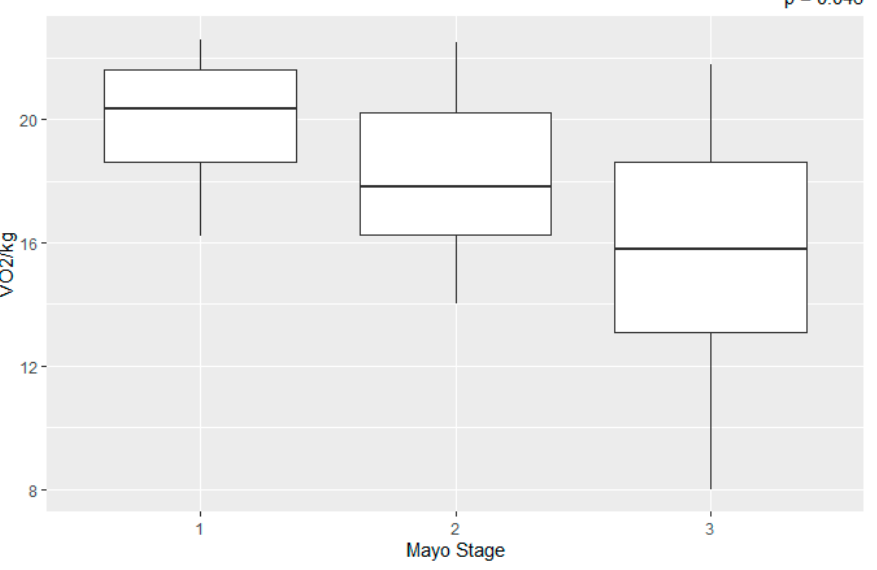
Figure 1. Peak relative VO2 in different Mayo stages.